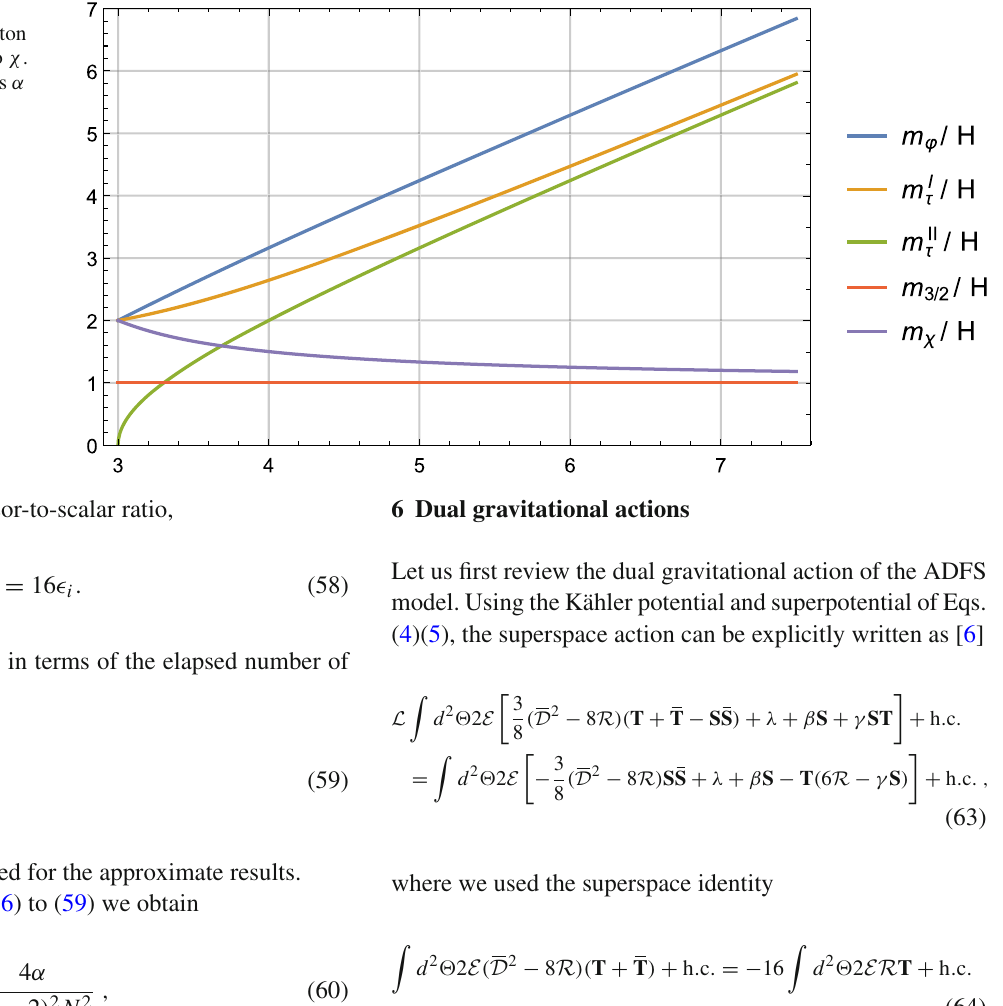
Fig. 3 The mass-to-Hubble ratios of the inflaton ϕ , sinflaton τ , gravitino ψ χ . m , and inflatino The horizontal axis represents